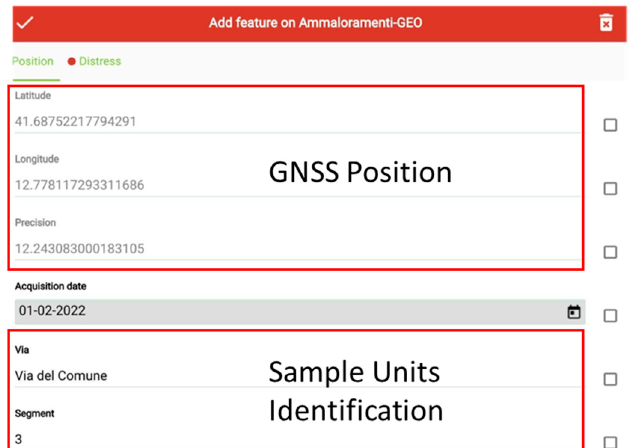
Figure 3. Position form.